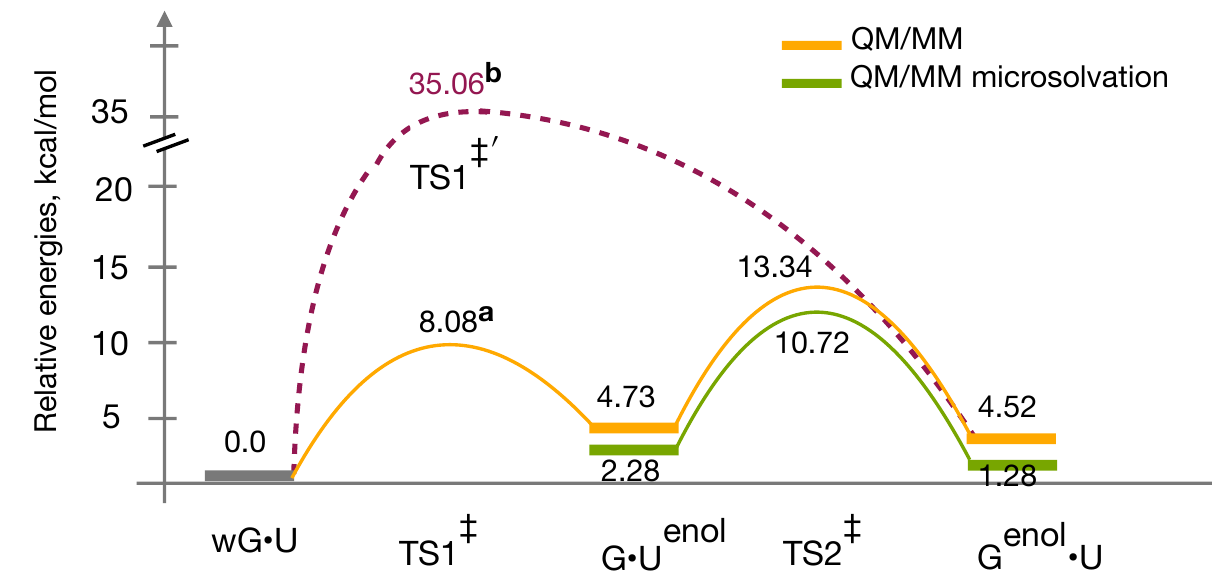
Figure 6. Reaction energy profiles of wG • U to WC-like tautomerization pathways obtained using QM/MM calculations. In case of the QM/MM energy profile with microsolvation two water molecules are included in addition to the G • U base pair in the QM-region. The energy profile depicted in purple colored dashed line is for wG • U → G enol • U pathway without the microsolvation. a and b refer to TS structures, which are obtained with slightly less tight convergence criteria, given in Tables S3 and S4 in the Supporting Information. Relative energies (kcal/mol) are calculated with respect to the wG • U base